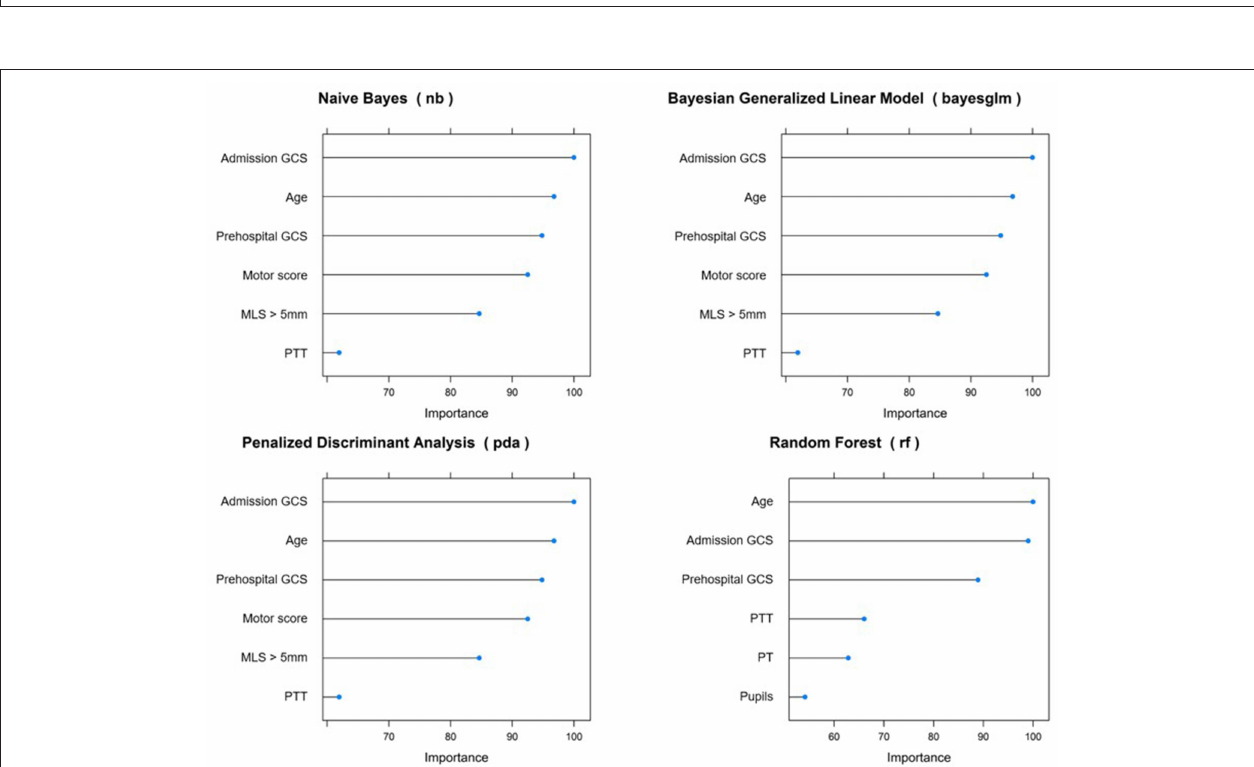
FIGURE 2 | Variable importance across top-performing predictive models for 14 day mortality. GCS, Glasgow Coma Score; MLS, midline shift; PTT, partial thromboplastin time; PT, prothrombin time.